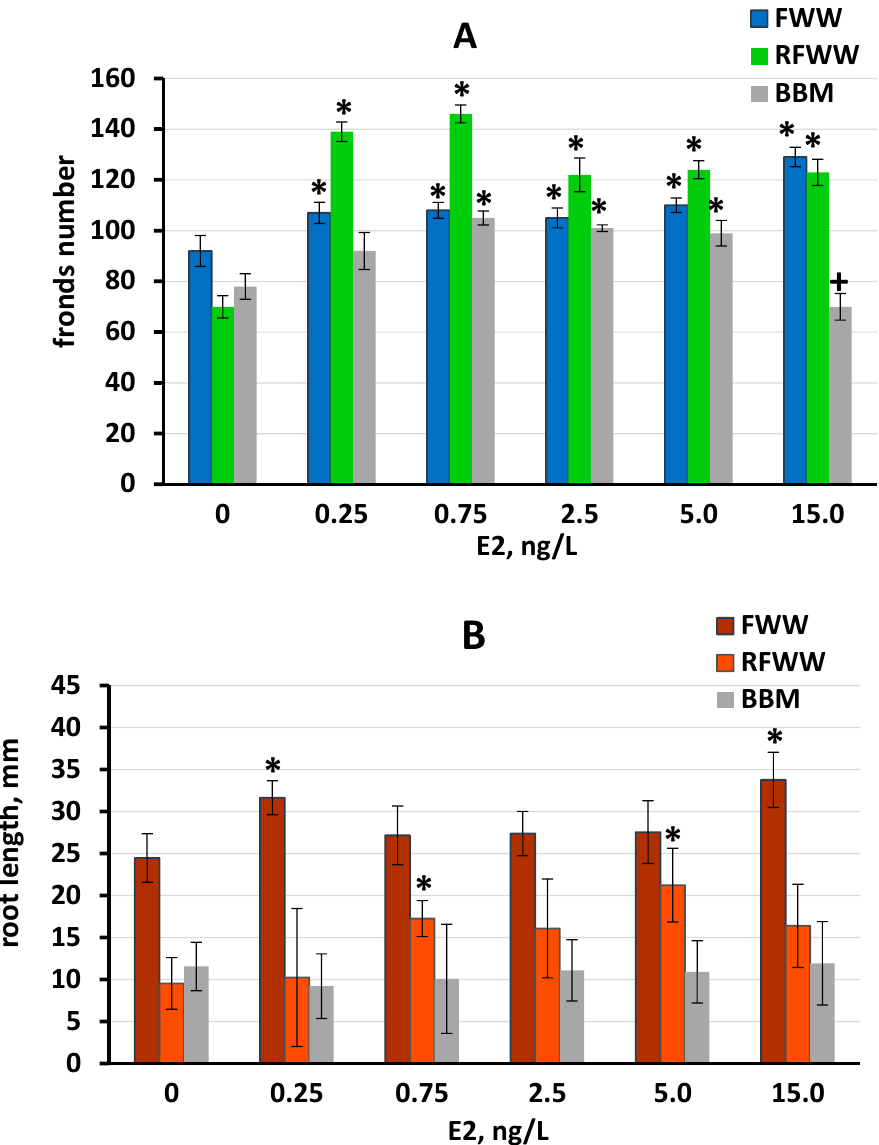
Figure 3. Growth of L. minor cultured in the three media containing E2 concentrations of 0.25 ng/L to 15 ng/L, on day 11 of the experiment: ( A ) foliage development in FFW, RFWW, and BBM media; ( B ) root length in FFW, RFWW, and BBM media. Statistically significant differences from the controls ( p < 0.05) are indicated, where *—significantly greater than the control; +—significantly lower than the control. Data are shown as the mean ± SD, n = 15. Control cultures did not contain E2, indicated by